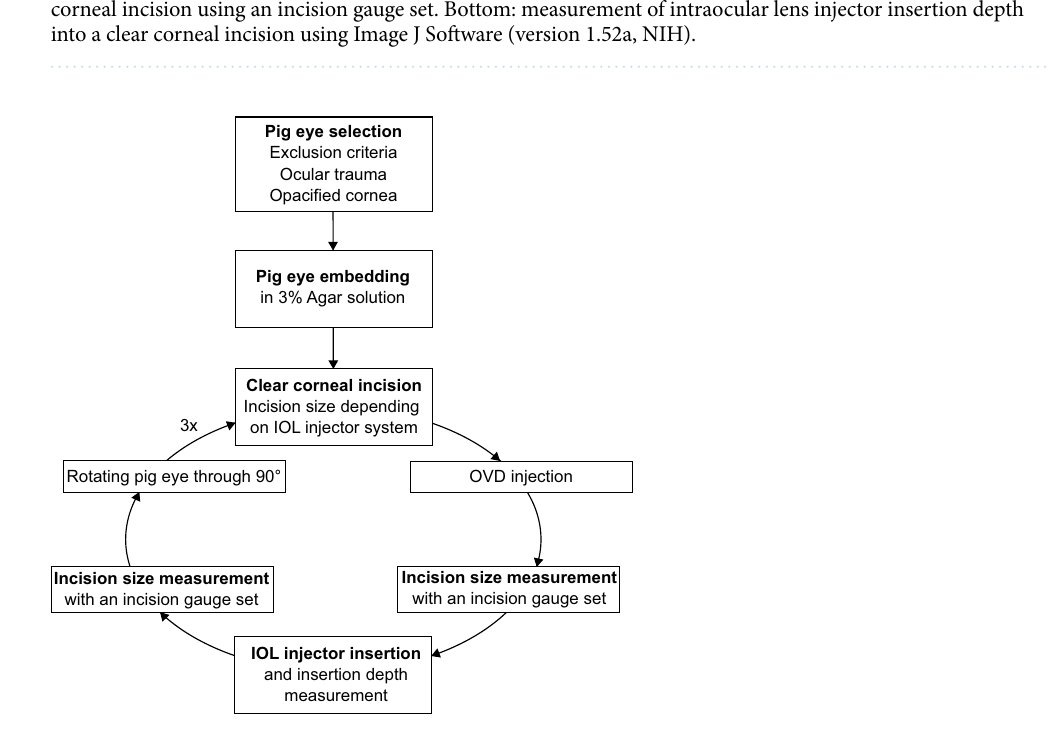
Figure 3. Visualization of the surgical process. OVD ophthalmic viscosurgical device, IOL intraocular